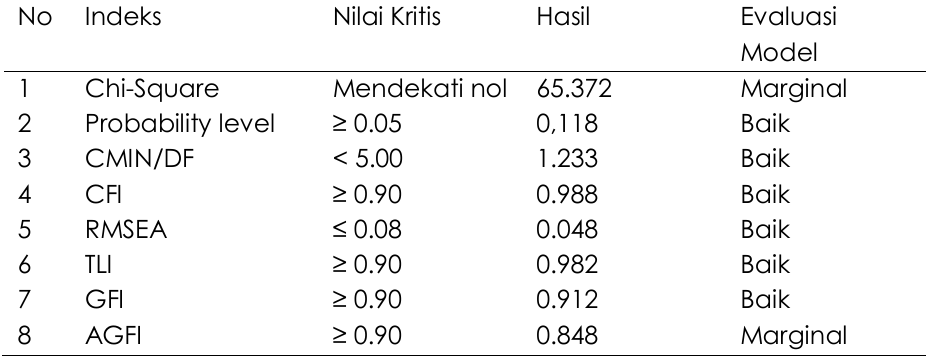
Tabel 6.Hasil Pengujian Goodness-of-fit Model